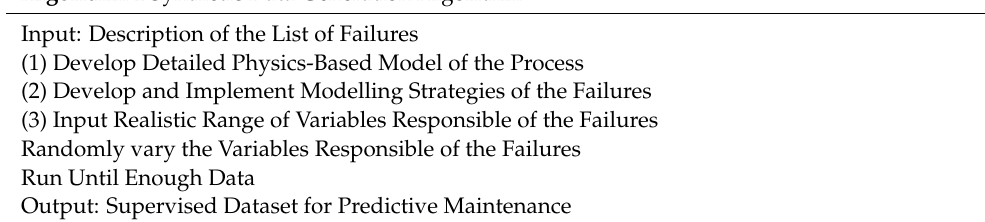
Algorithm 1 Synthetic Data Generation